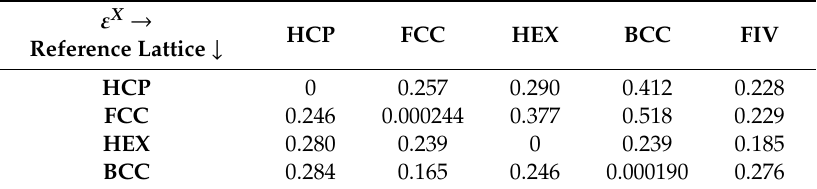
Table 3. Characteristic Crystallographic Element (CCE) norm, ε X , when the analysis is applied on reference 3-D hexagonal close packed (HCP), face centered cubic (FCC), hexagonal (HEX) and body centered cubic (BCC) crystals. Also reported are results from CCE application with respect to the fivefold (FIV) local symmetry.